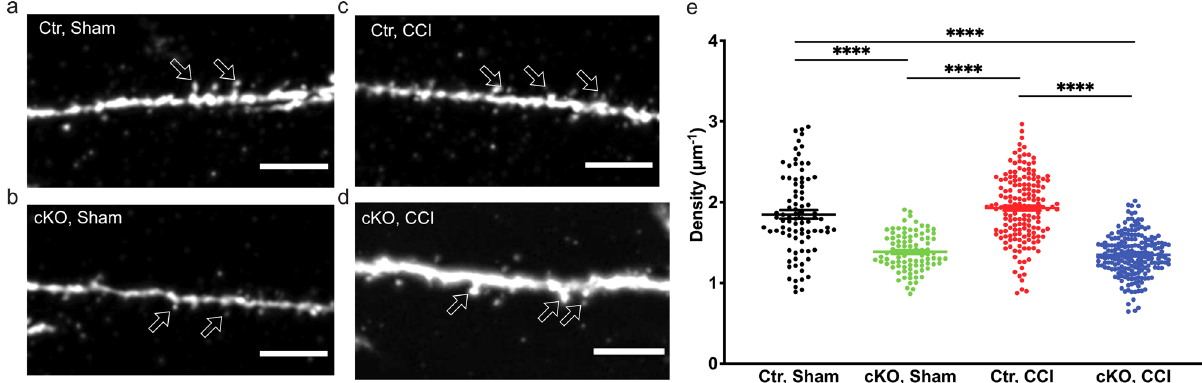
Fig. 5 Lack of astrocytic ApoE results in the reduction of spine density in newborn neurons. a – d Representative images illustrate the distribution of the spines in the dendrites in newborn neurons. e The reduction of astrocytic ApoE was the main factor, not CCI, that resulted in reduced spine density in newborn neurons. Arrows indicate the spines. Data are presented as means ± SEM. ****P < 0.0001 . Scale bar = 5 μ ( F 1,52 = 0.28, NS) were not signi fi cant. No signi fi cant differences the genotype x operation interaction ( F 1,48 = 2.56, NS). In the were found in pre-cue freezing or cued freezing on day 3. open- fi eld test (Fig. 8c), two-way ANOVA revealed a signi fi cant effect of operation, with CCI mice showing increased distance traveled in the open fi eld ( F 1,52 = 4.11, P = 0.0477). Effects of genotype ( F 1,52 = 0.59, NS) and genotype x operation interaction ( F 1,52 = 0.25, NS) were not signi fi cant. Results of the open- fi eld Fig. 8a, b, in the elevated plus-maze test, two-way ANOVA test ruled out gross motor impairments in cKO mice. revealed a signi fi cant effect of genotype on % time in the open arms, which is reduced in cKO mice ( F 1,48 = 7.88, P = 0.0072). The main effect of operation ( F 1,48 = 1.48, NS) and the interac- tion between genotype and operation ( F 1,48 = 2.59, NS) were not signi fi cant. For total arm entries, no signi fi cant effects were found for genotype ( F 1,48 = 0.22, NS), operation ( F 1,48 = 0.00, NS), or